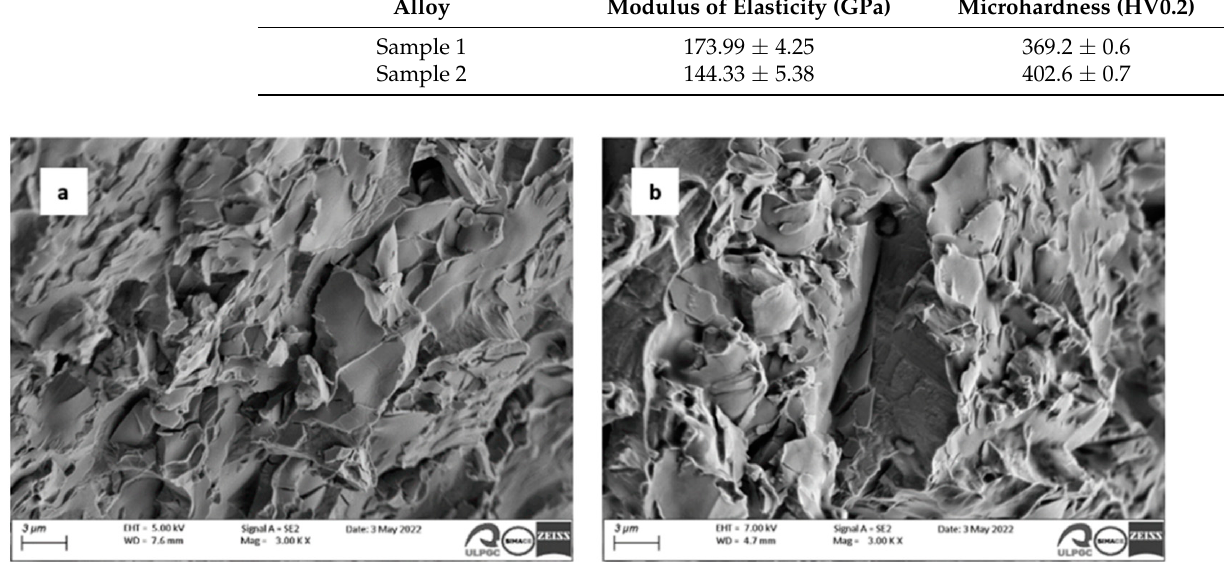
Figure 4 . SEM images of the fracture after three-point bending test: ( a ) Sample 1 and ( b ) Sample 2. 3.3. Electrochemical Measurements The samples were immersed in 3.5% NaCl solution, and the open-circuit potential (OCP) was recorded as a function of time up to 24 h. The OCP values changed continu- ously, fluctuating more rapidly during the first hours of immersion and reaching rela- tively stationary values only after 24 h. Was observed that the OCP values after 24 h of immersion were negative for both Sample 1 ( − 342 ± 63 mV vs. SCE) and Sample 2 ( − 458 ± 43 mV vs. SCE). This negative shift was related to the alteration of the film from the sample